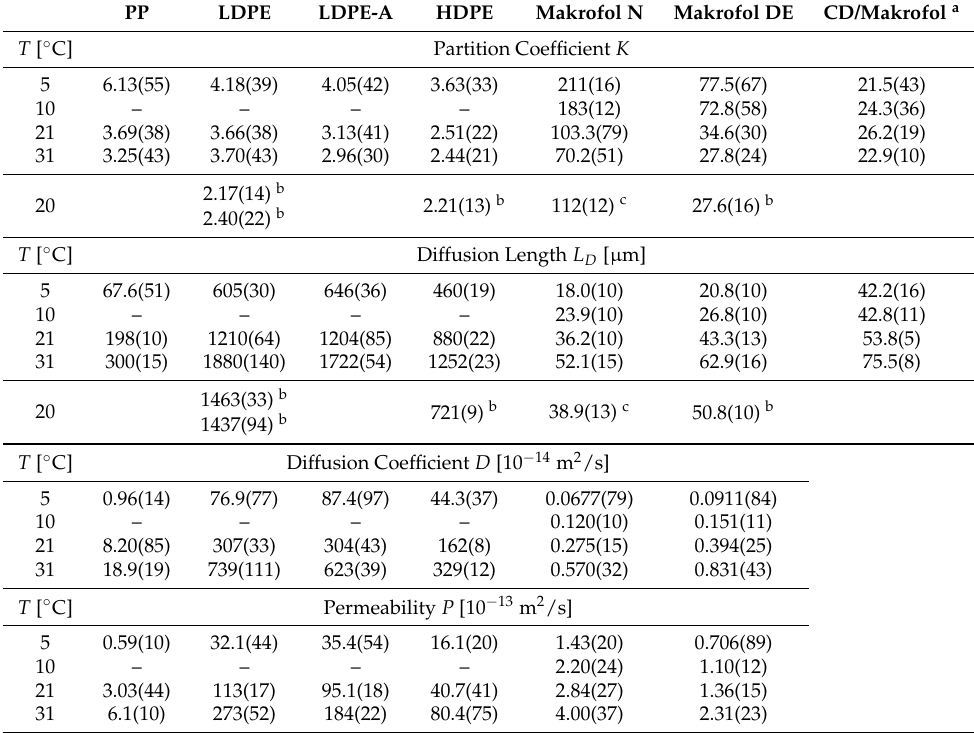
Table 3. Partition coefficients polymer–air, diffusion lengths, diffusion coefficients and permeabilities of radon for the studied polymers at different temperatures. The temperature was kept constant within 1 ◦ C. All uncertainties are at the level of 1 σ . For comparison, values obtained in previous studies are